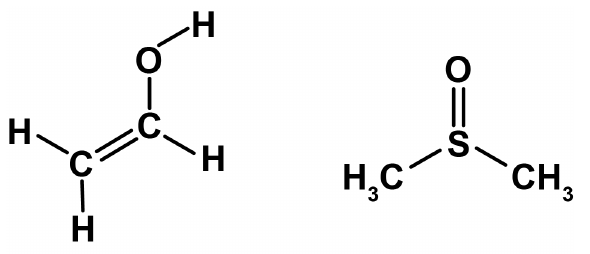
Figure 4. The structure of vinyl alcohol ( left ); the structure of DMSO ( right ).